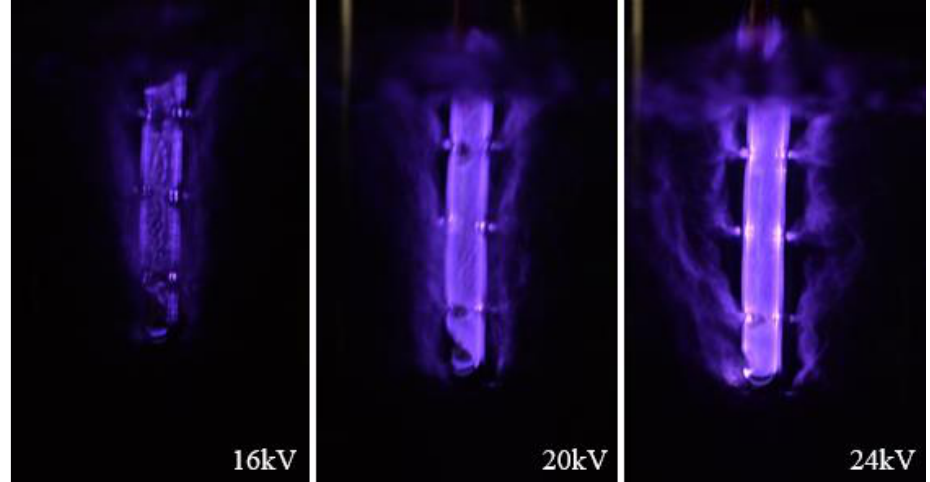
Figure 4. Discharges in the tap water at different applied voltages (Pictures taken by Nikon D750, exposure time 50 ms). Figure 5 captured the simultaneous discharge of four DBD devices driven by 20